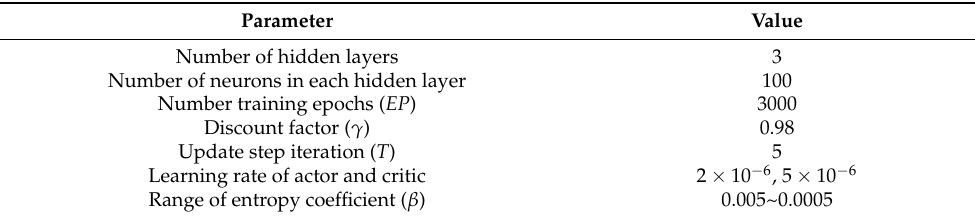
Table 2. Parameter settings for the training process and DRL